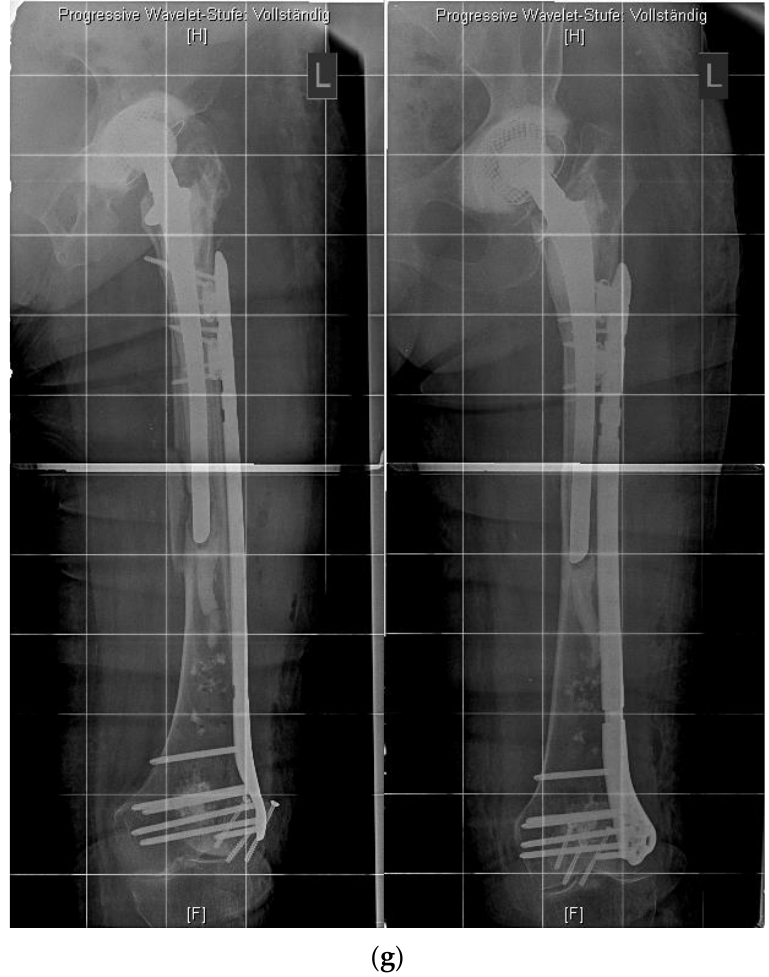
Figure 3. ( a ) LOQTEQ VA Periprosthetic Plate (with kind permission of aap Implantate AG, Berlin, Germany). ( b ) Insertable hinge with each of the two variable angle screw options (with kind permission of aap Implantate AG, Berlin, Germany). ( c ) Periprosthetic fracture around a cemented stable total hip revision arthroplasty. ( d ) LOQTEQ VA Periprosthetic Plate with mounted aiming device. ( e ) LOQTEQ VA Periprosthetic Plate with four inserted hinges. ( f ) Variable angle screw placement around the hip revision stem. ( g ) Postoperative X-rays. Four hinges with each of the two variable angle screw options were used to fix the plate around the hip stem.